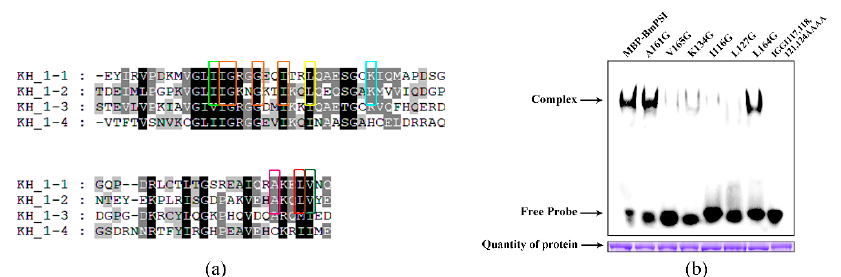
Figure 2. Important amino acids in the KH_1-1 motif of BmPSI: ( a ) Comparison among amino acid sequences of the KH_1 motifs in BmPSI. The black color represents that amino acids are completely identical. The gray color represents that partial amino acids are identical. Different colored boxes represent different potential key amino acid sites for the binding. ( b ) After the concentrations were adjusted uniformly, EMSA was performed on wild-type BmPSI and seven amino acid mutants of BmPSI.